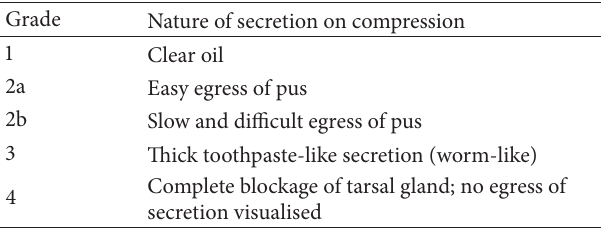
Table 1: COTE grading